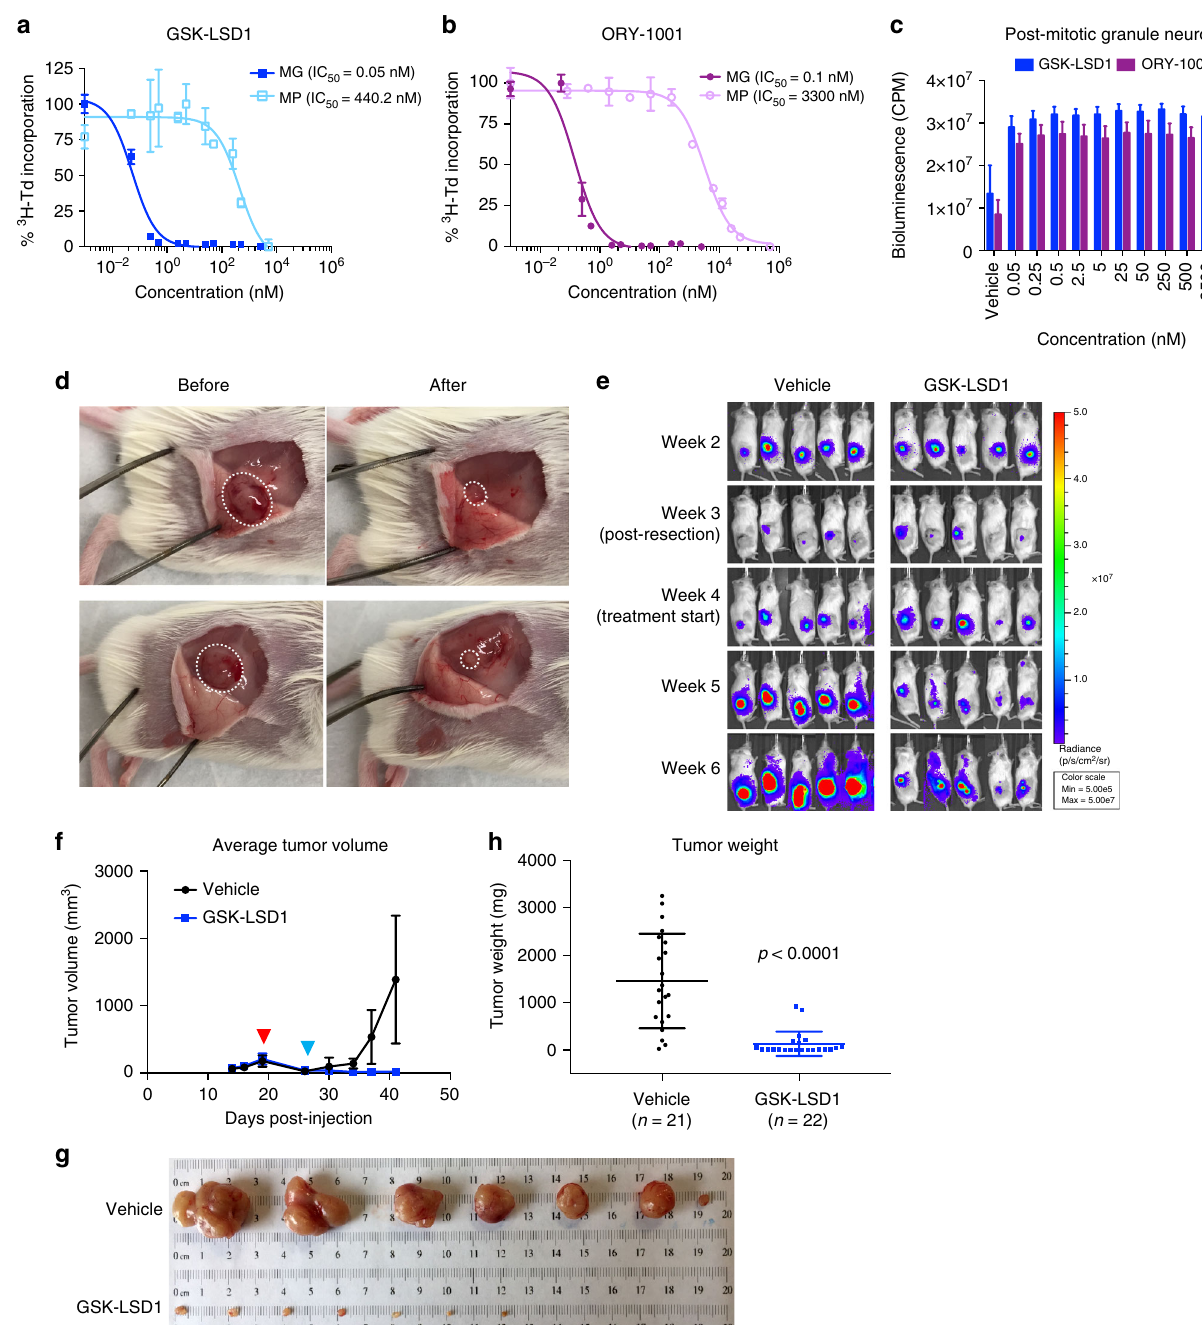
Fig. 7 Pharmacological inhibitors of Lsd1 inhibit growth of G fi 1-driven MB. a , b In vitro proliferation assays for MG and MP tumor cells treated with a GSK- LSD1 or b ORY-1001. Proliferation was measured via 3 H-thymidine incorporation at 48hrs. c Cell viability of post-mitotic granule neurons treated with GSK- LSD1 (blue) or ORY-1001 (purple). Viability was measured via CellTiter-Glo Luminescent Assay at 48 h. Data shown in a – c are from representative experiments and are plotted as the means of technical triplicate samples ± SEM. All experiments were repeated in at least three biological replicates. d – h Mice implanted with subcutaneous MG tumors underwent surgical resection of tumors and were subsequently treated with vehicle (saline) or 10 mg/kg GSK-LSD1 in cycles of four days on and three days off (vehicle n = 21, GSK-LSD1 n = 22). d Representative images of two tumors before (left) and after (right) surgical resection. Tumors are outlined by white dotted lines. Tumor growth was monitored weekly by e bioluminescent imaging and f caliper measurements. Red arrowhead indicates time of surgical resection. Blue arrowhead indicates start of drug treatment. Data shown are from a representative experiment and are plotted as the means ± SEM. When tumors reached the maximum allowed diameter, mice were sacri fi ced and resulting tumors were g collected and h weighed. Compared to resection alone, resection and GSK-LSD1 treatment signi fi cantly reduced tumor burden in mice. p < 0.0001, t = 6.042, d f = 41, one-tailed unpaired t test. Data shown in h are from three replicate experiments and plotted as the means ±